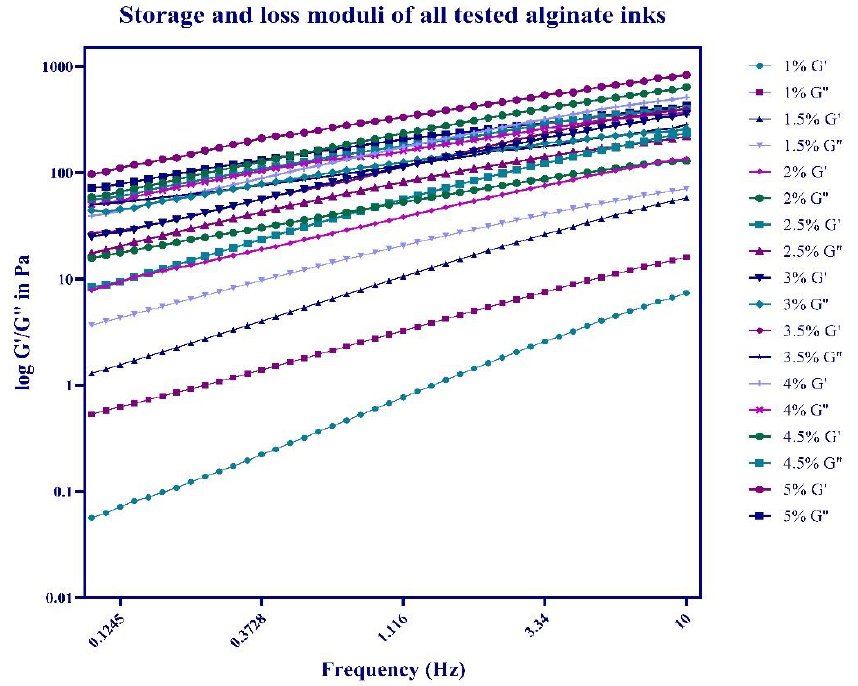
Figure 4. Assessment of rheological parameters of different bioink formulations. The storage ( G′ ) and loss ( G″ ) moduli (in Pa) obtained during oscillation frequency sweep of all the bioinks tested are presented. Figure legend corresponds to percentages of different alginates tested. Results were collected from six different samples and are presented as means ± SD. Error bars are not visible on the graph due to small degrees of variation.